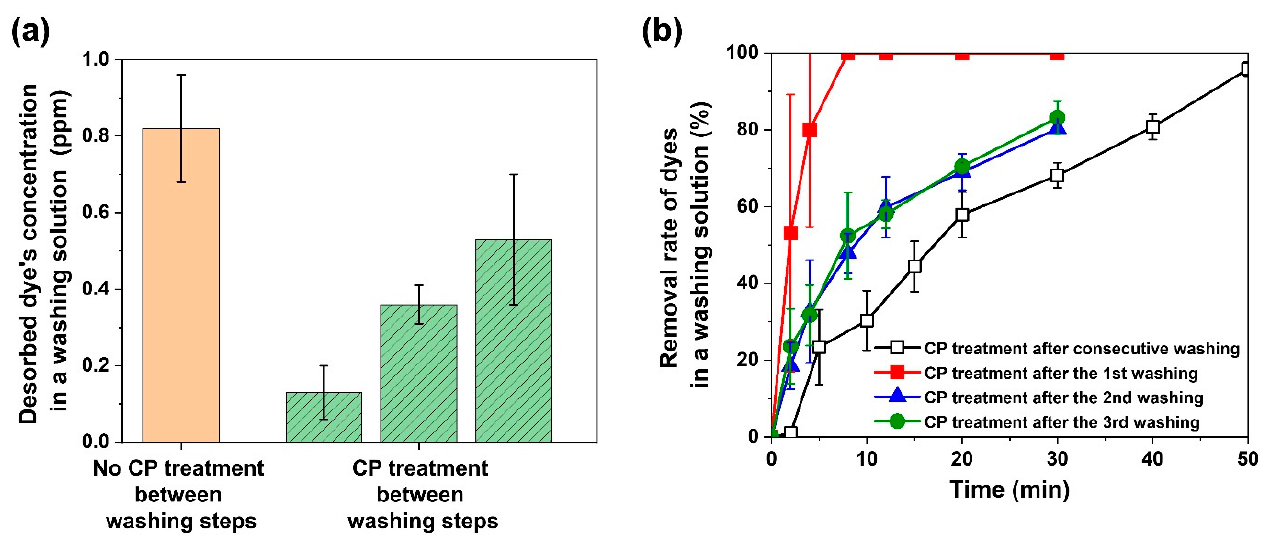
Figure 5. ( a ) Desorbed dye’s concentration in a washing solution measured just before CP treatment began ( n = 3). ( b ) Removal rate of dyes in a washing solution observed at different times during CP treatment ( n = 3). The open square indicates the dye removal rate measured during CP treatment after consecutive washing three times without CP treatment between washing steps, while the close square, triangle, and circle signify the cases for the CP treatment between washing steps.